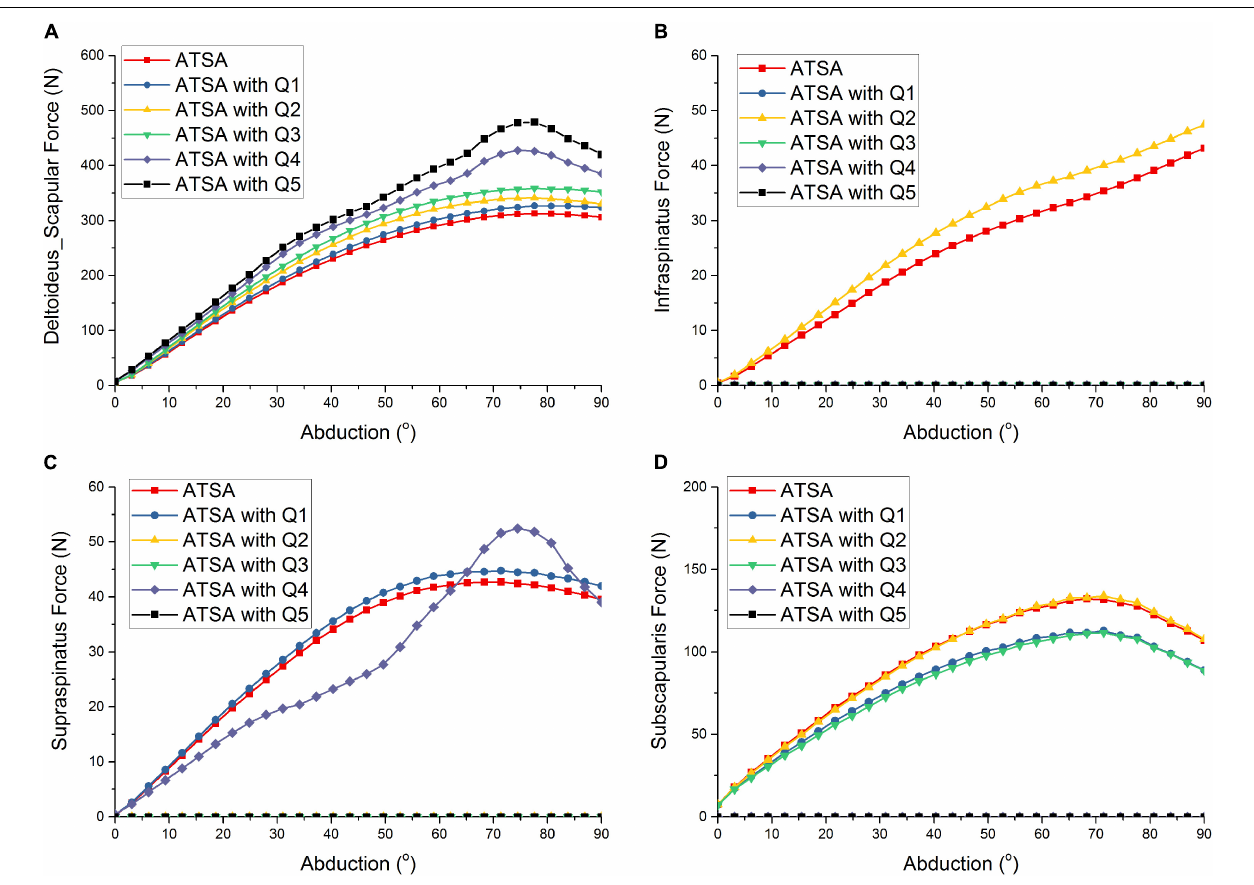
FIGURE 3 | Predicted deltoideus_scapular force (A) , infraspinatus force (B) , supraspinatus force (C) , subscapularis force (D) of ATSA under intact rotator cuff and different rotator cuff deficiencies. Q1: infraspinatus deficiency; Q2: supraspinatus deficiency; Q3: supraspinatus and infraspinatus deficiencies; Q4: subscapularis deficiency; Q5: supraspinatus, infraspinatus, subscapularis, and teres minor